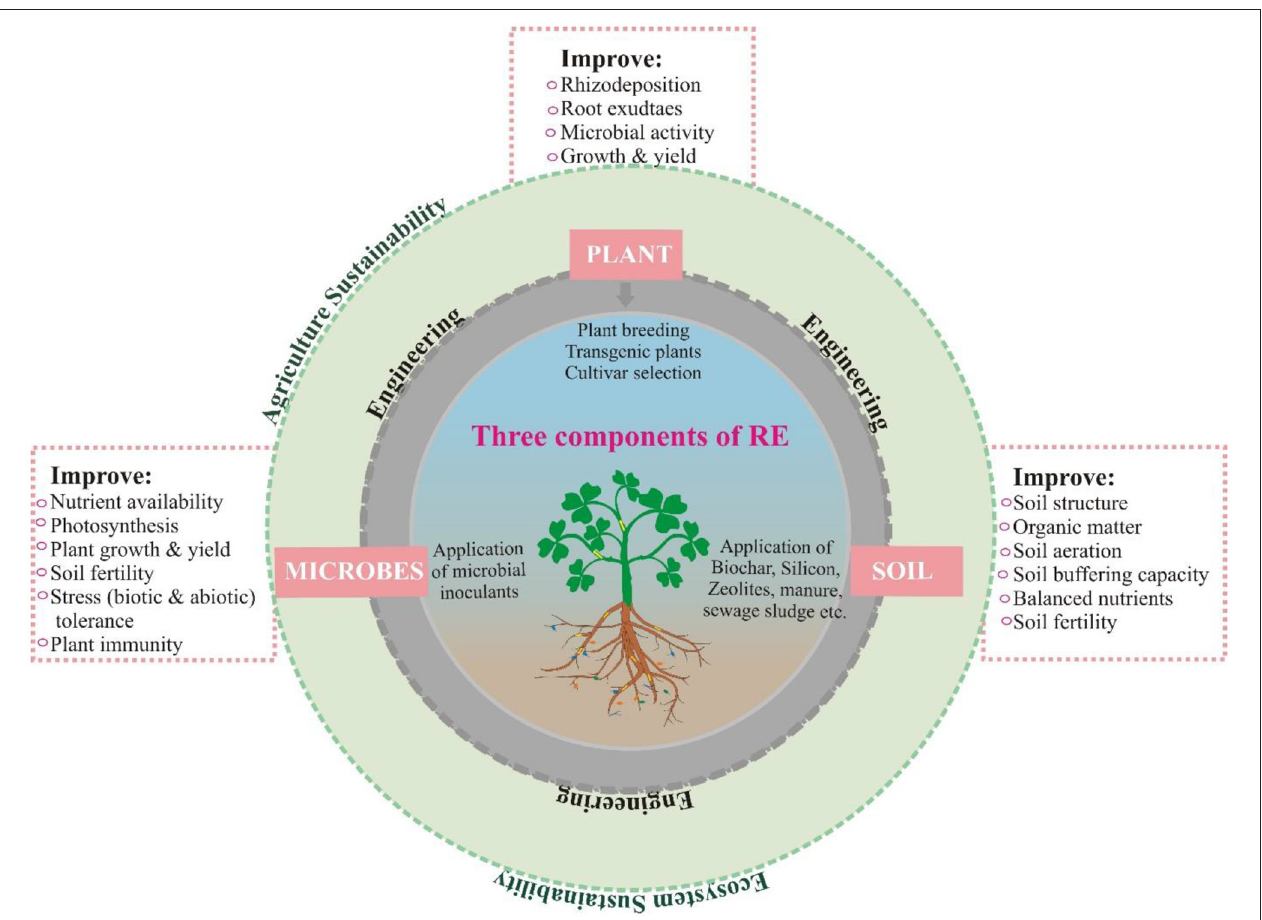
FIGURE 1 | The key components of rhizosphere engineering and intricate relationship of these